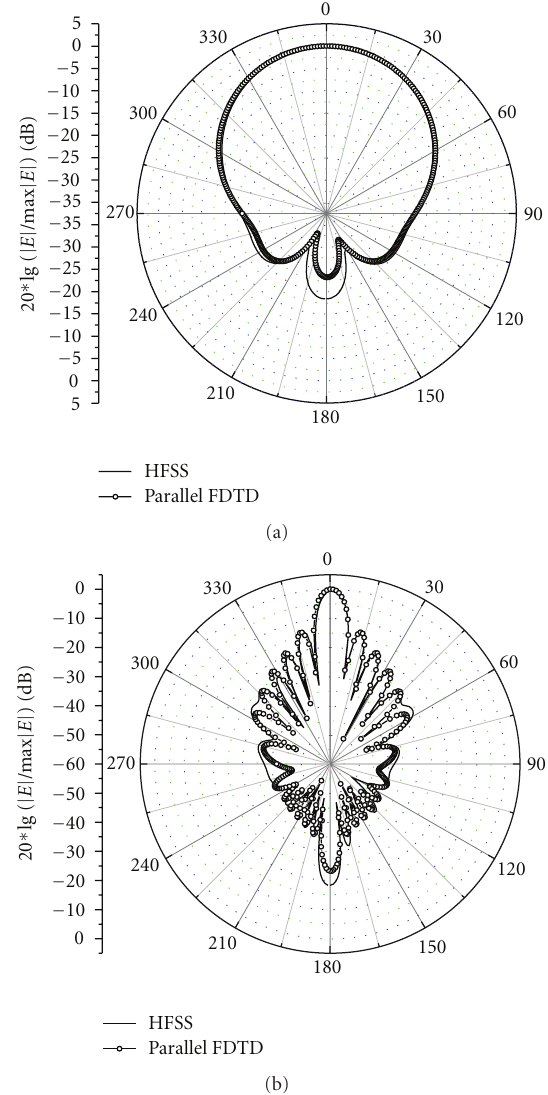
Figure 6: Results of radiation: (a) radiation pattern of the x o y plane and (b) radiation pattern of the yoz